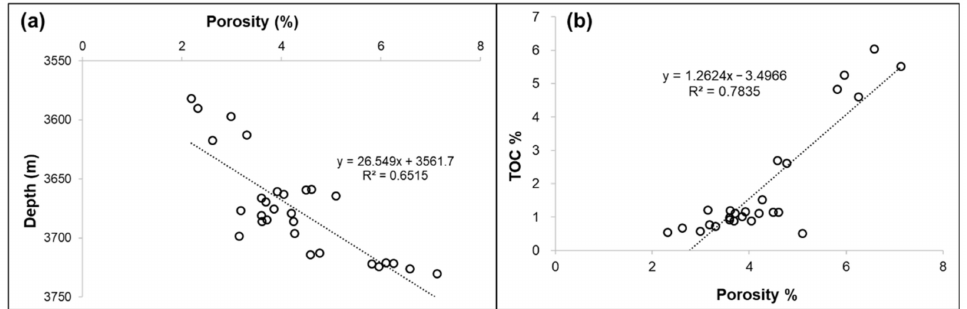
Figure 6. The plots of porosity vs. depth ( a ) and porosity vs. TOC ( b ) of core samples from Well A in Sichuan Basin, with both showing positive relationships.